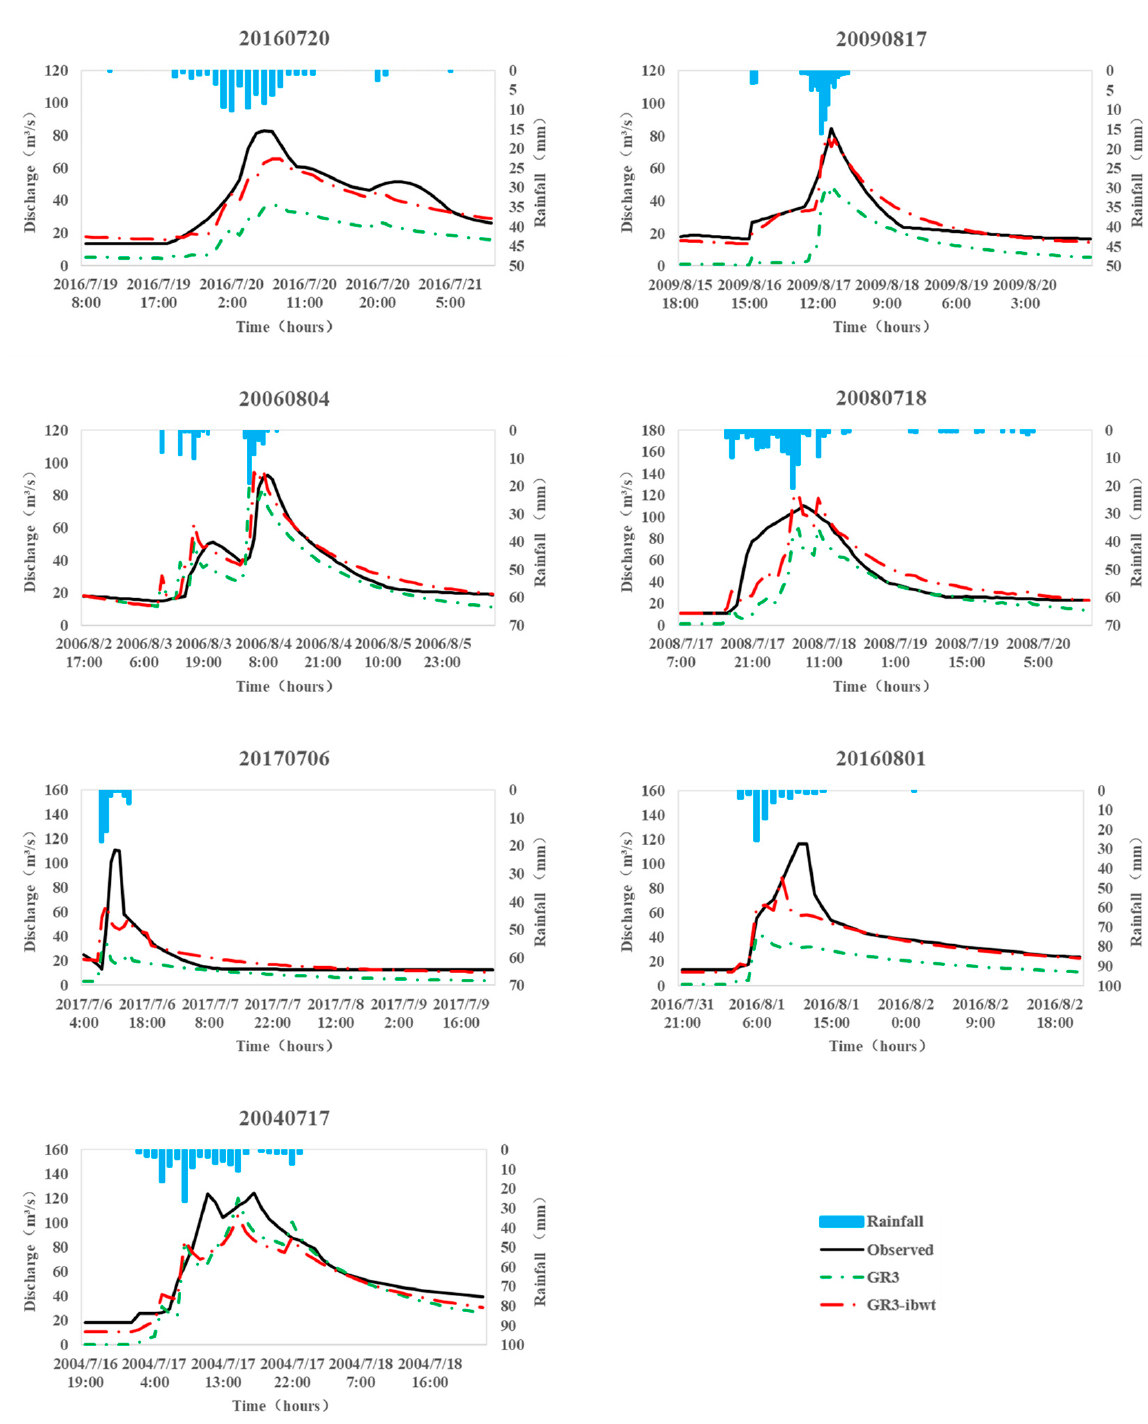
Figure 7. Time history of discharge at the outlet gauging station in medium flood processes .